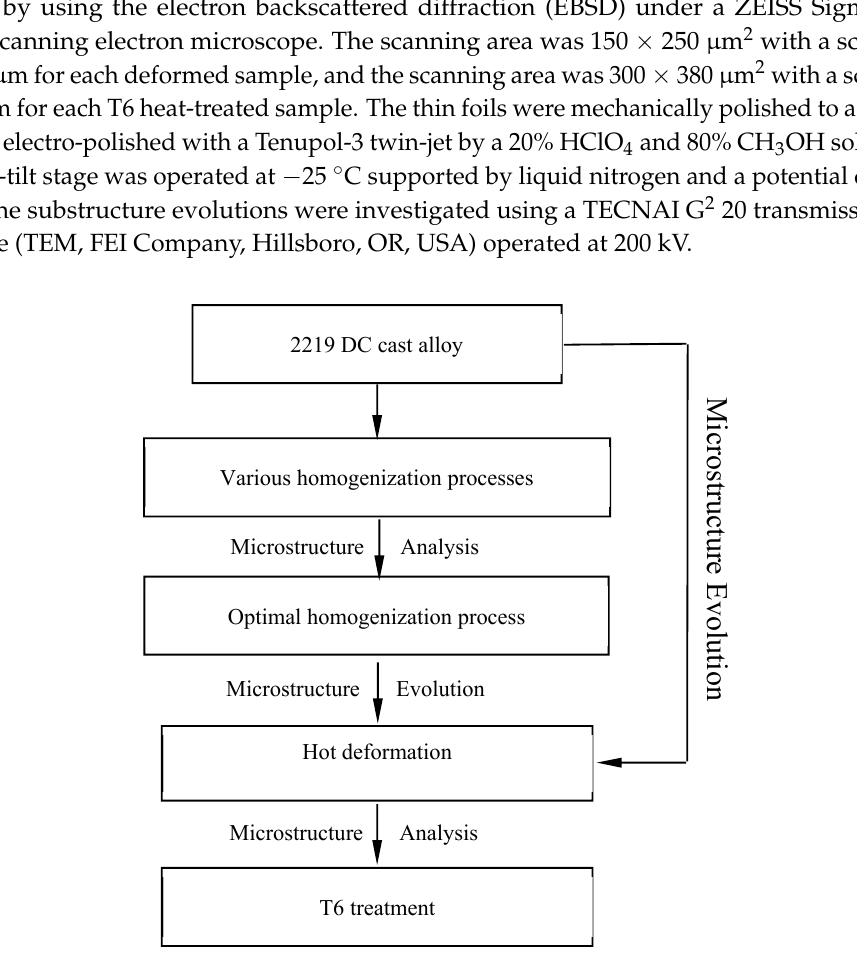
Figure 1. Experimental procedures applied to the AA2219 direct chill (DC) cast alloy.